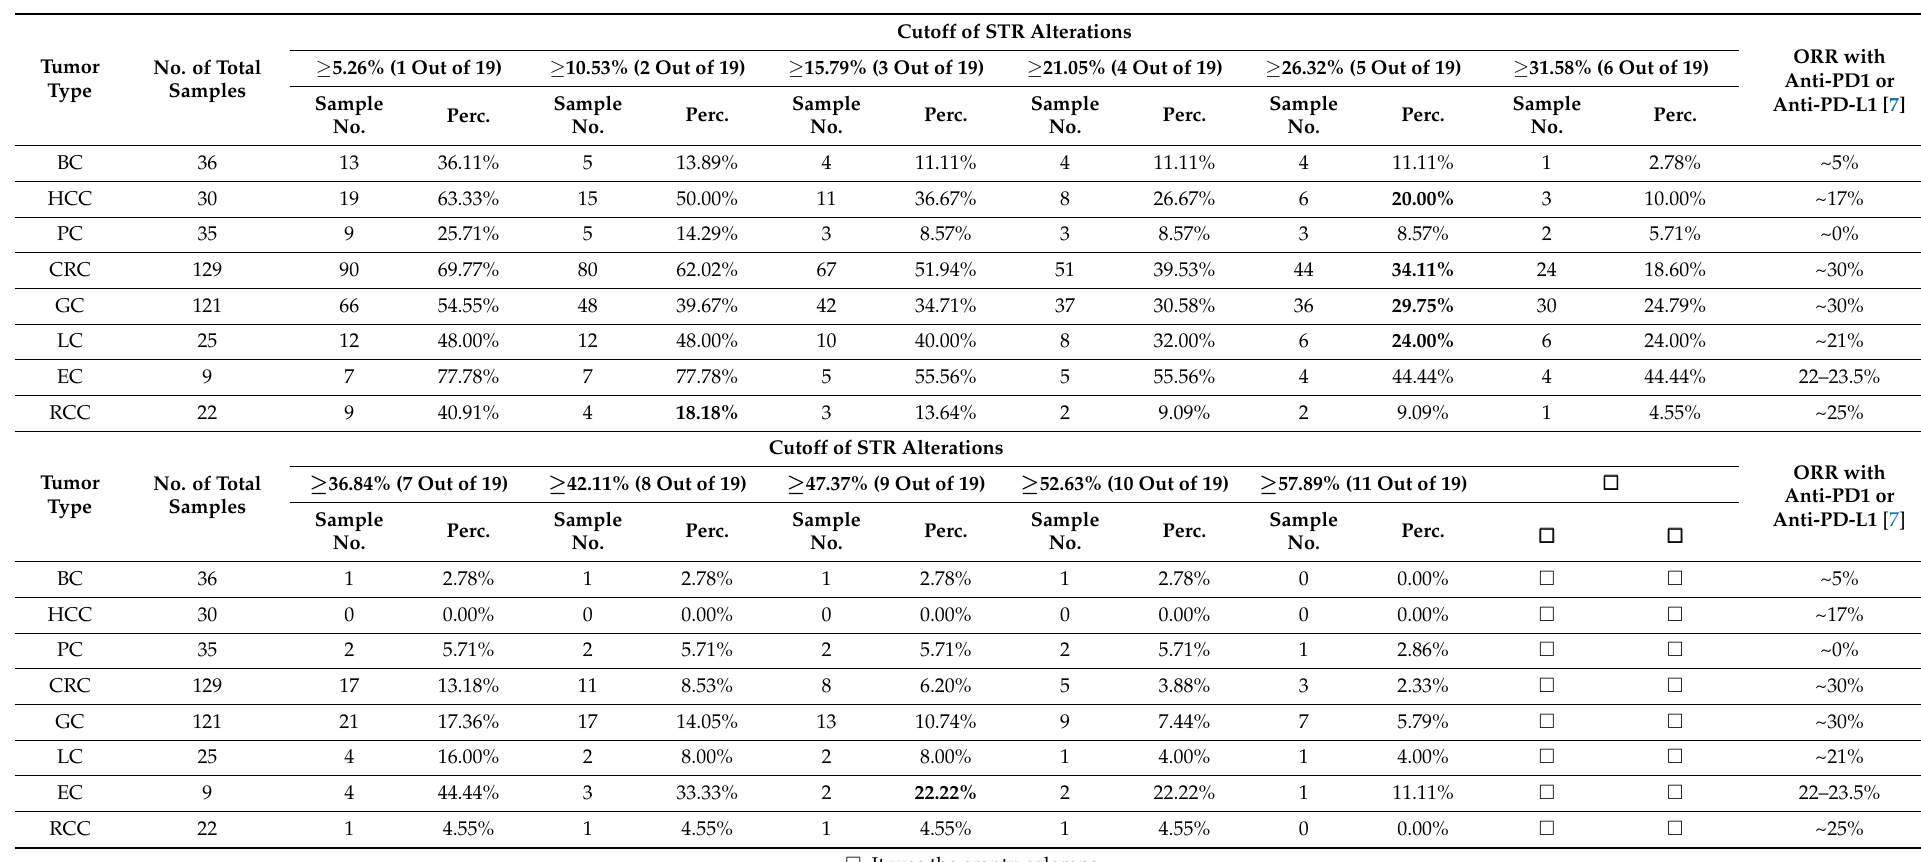
Table 4. The percentage of STR positive samples in different cutoff values. The bold fonts refer to the most suitable cutoff value for the STR alterations; Perc. refers to the STR alteration